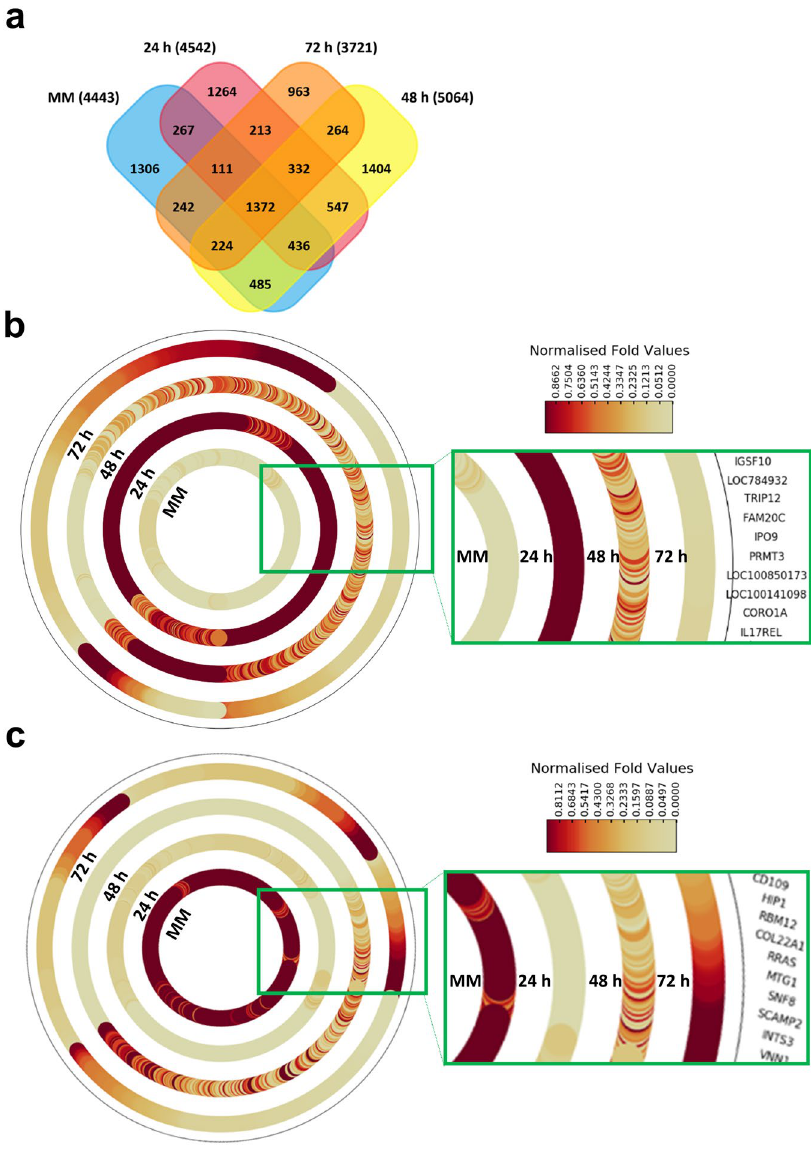
Figure 3. Proteomics analysis of exosomes isolated from MM and colostrum. ( a ) A four-way Venn diagram of proteins distributed between 24, 48, 72 h colostrum and MM exosome samples revealing 1372 proteins common to all dataset. ( b ) Heatmaps showing proteins that are 3-fold more abundant in exosomes isolated from 24 h colostrum samples compared to MM. A distinct pattern was revealed where proteins that were seen to be highly abundant in 24 h colostrum exosomes steadily diminished in 48 and 72 h colostrum exosomes and reached similar levels to the MM exosomes. ( b ) Proteins that are 3-fold more highly abundant in exosomes isolated from MM samples compared to 24 h colostrum sample were also plotted as a heatmap and revealed a similar distribution